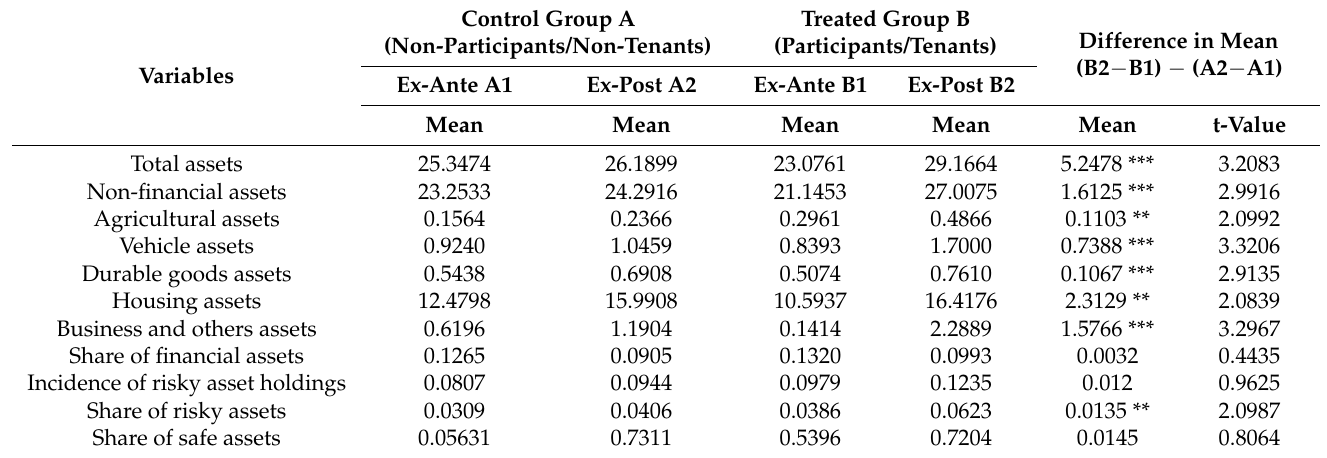
Table 2. Descriptive statistics of household assets before and after participating in the farmland rental